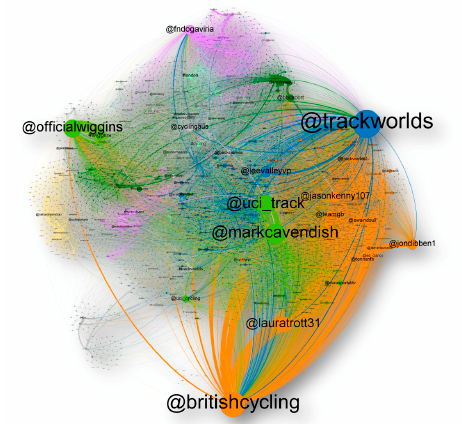
Figure 2. Interaction graph of the event with hashtag #TWC2016.